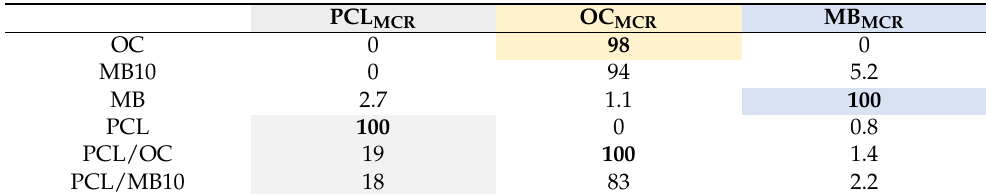
Table 2. The occurrence of spectral components calculated by multivariate curve resolution— alternating least squares in the infrared spectra of simple and multicomponent